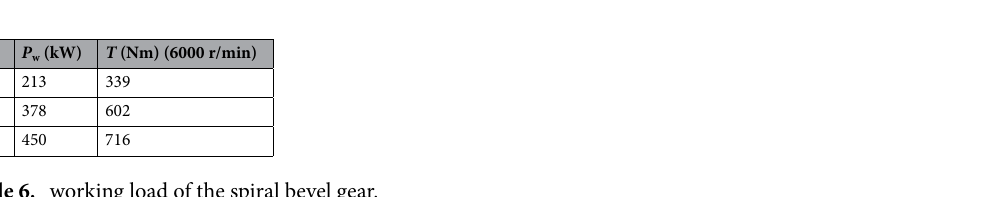
Table 6. working load of the spiral bevel